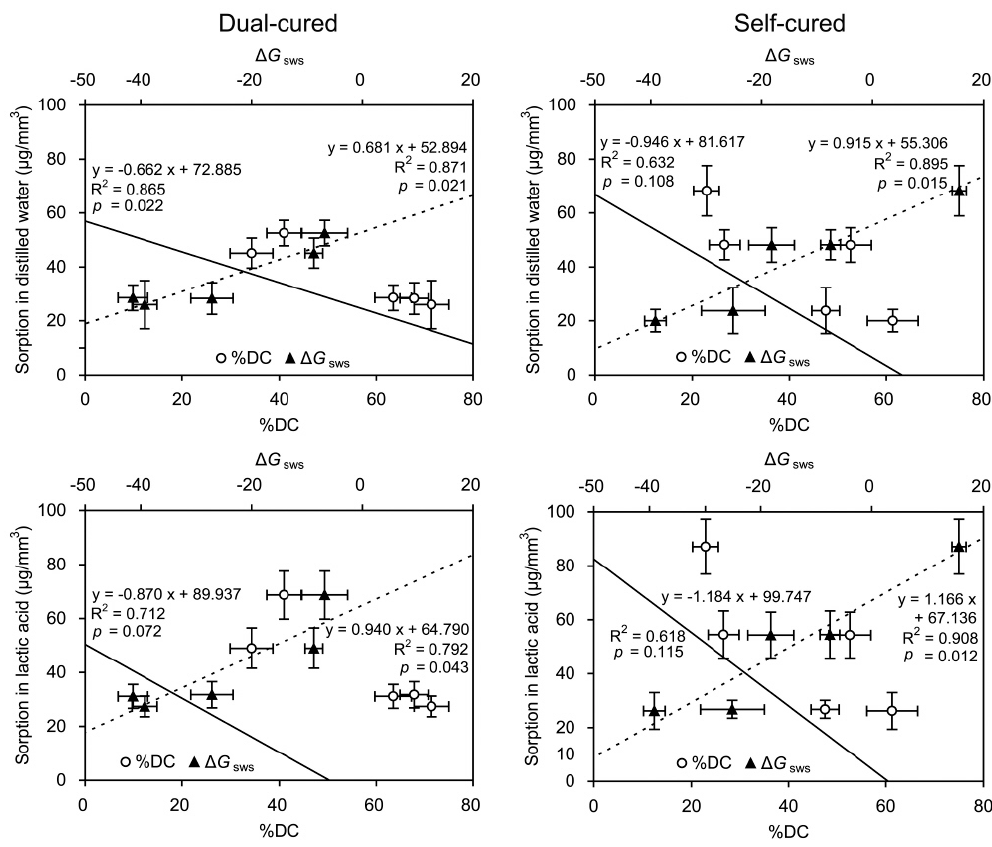
Figure 6. Graphs of linear regression of sorption ( μ g/mm 3 ) as a function of degree of conversion (%DC) and degree of hydrophilicity ( Δ G sws ). The horizontal and vertical bars indicate standard deviations.